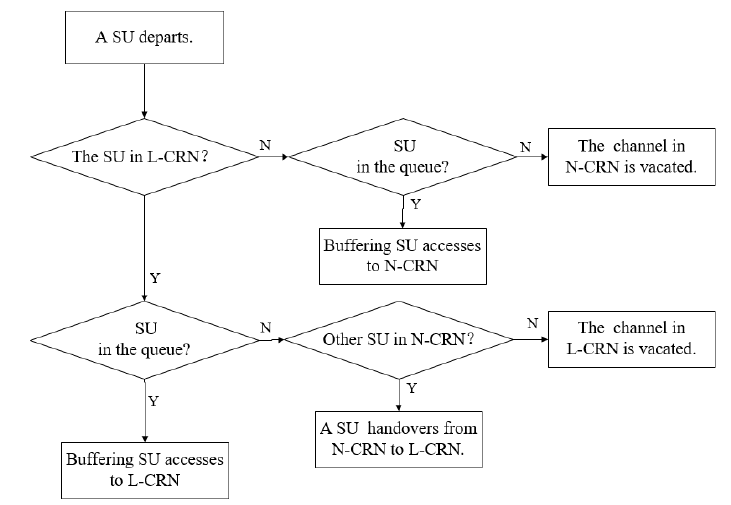
Figure 6. The procedure when a SU